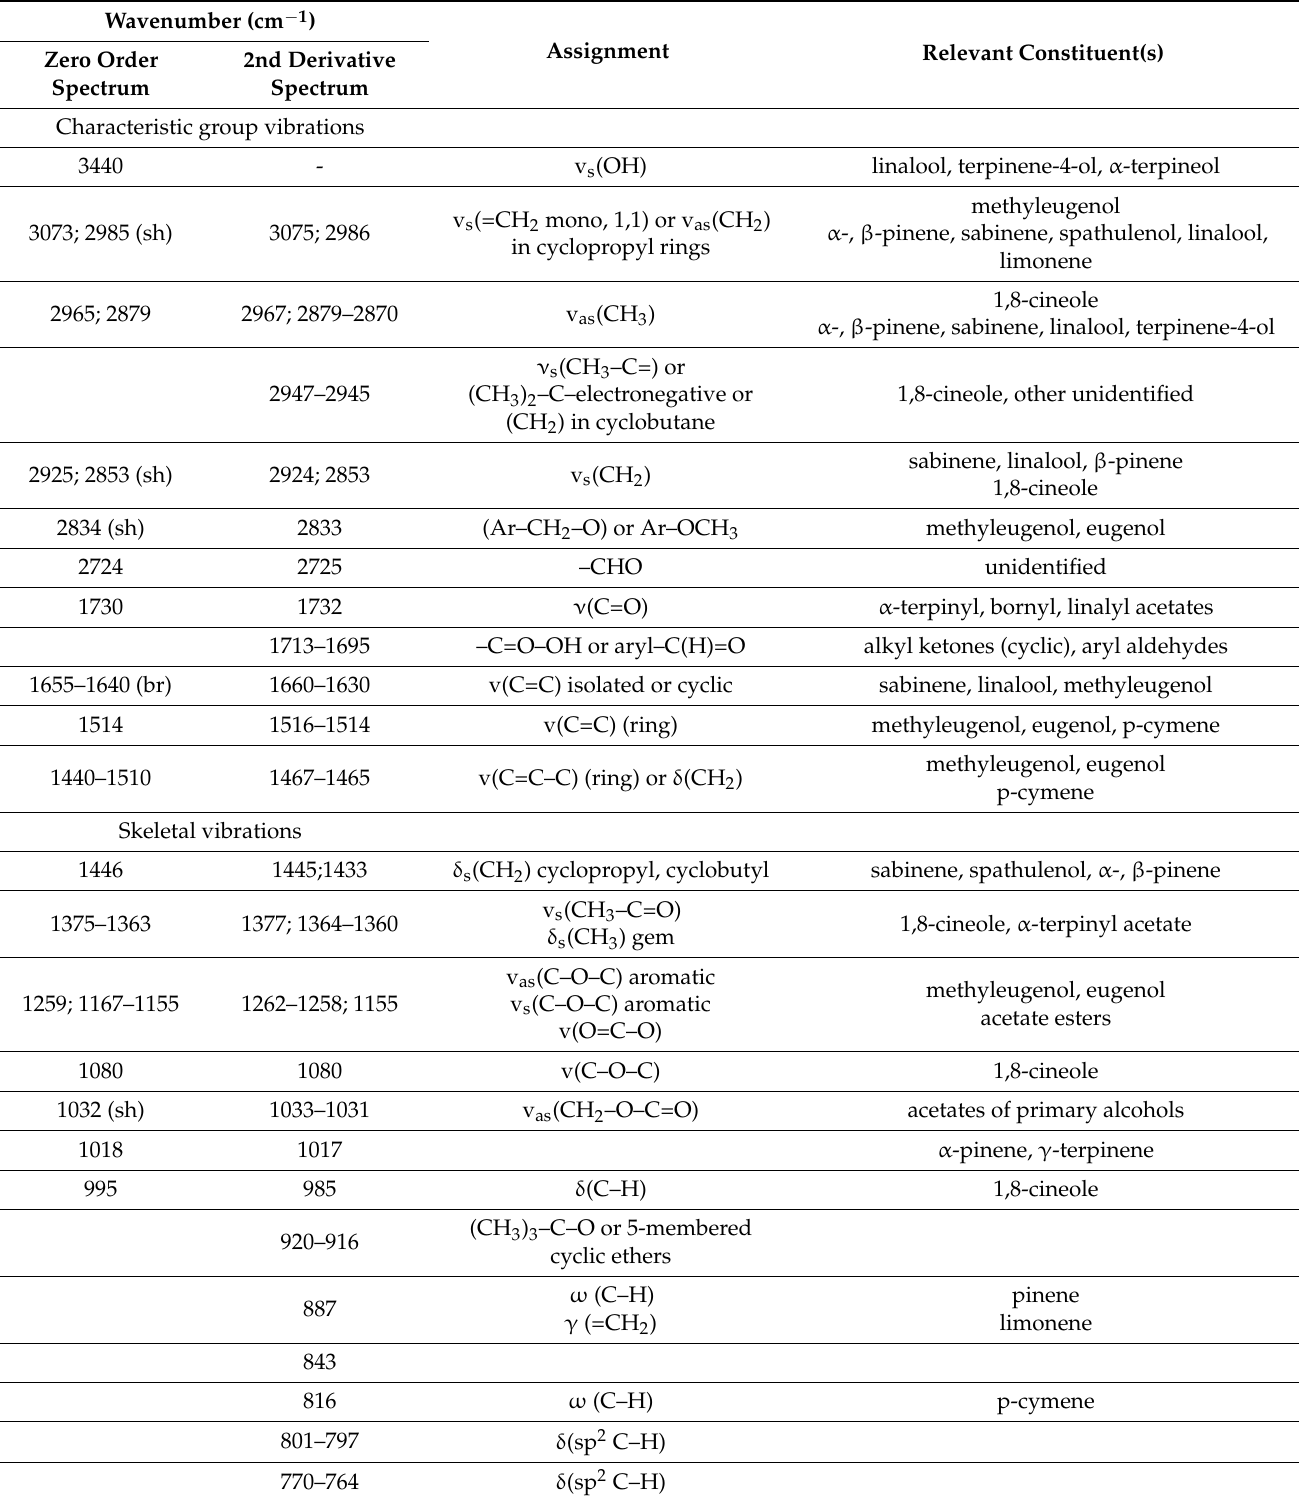
Table 3. Assignment of the most characteristic bands in the FT-IR transmittance mode spectra of bay laurel leaf EOs based on literature [43,44] and spectra of reference compounds (data from Table 1 in